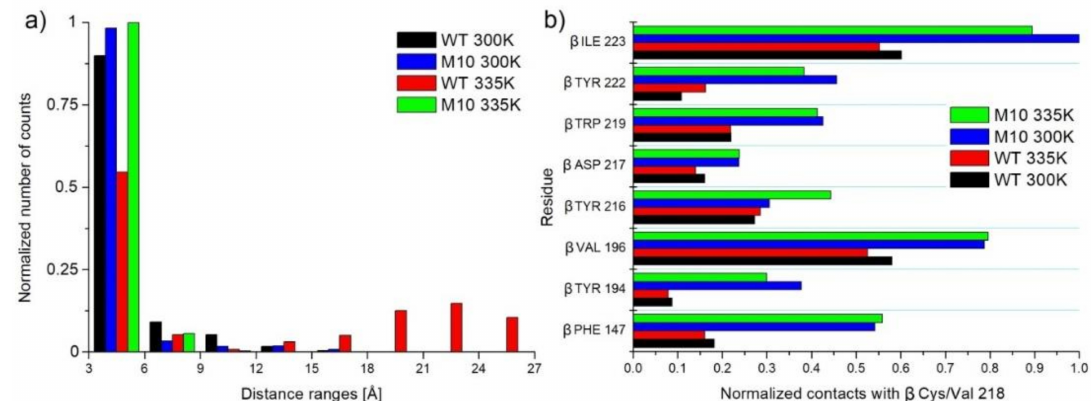
Figure 15. ( a ) Histogram of distances between C ζ atom of β Arg131 and C δ atom of β Glu188. Distance below 6 Å indicates the creation of the salt bridge between these residues. ( b ) Interactions of β Cys / Val218 with neighbor amino